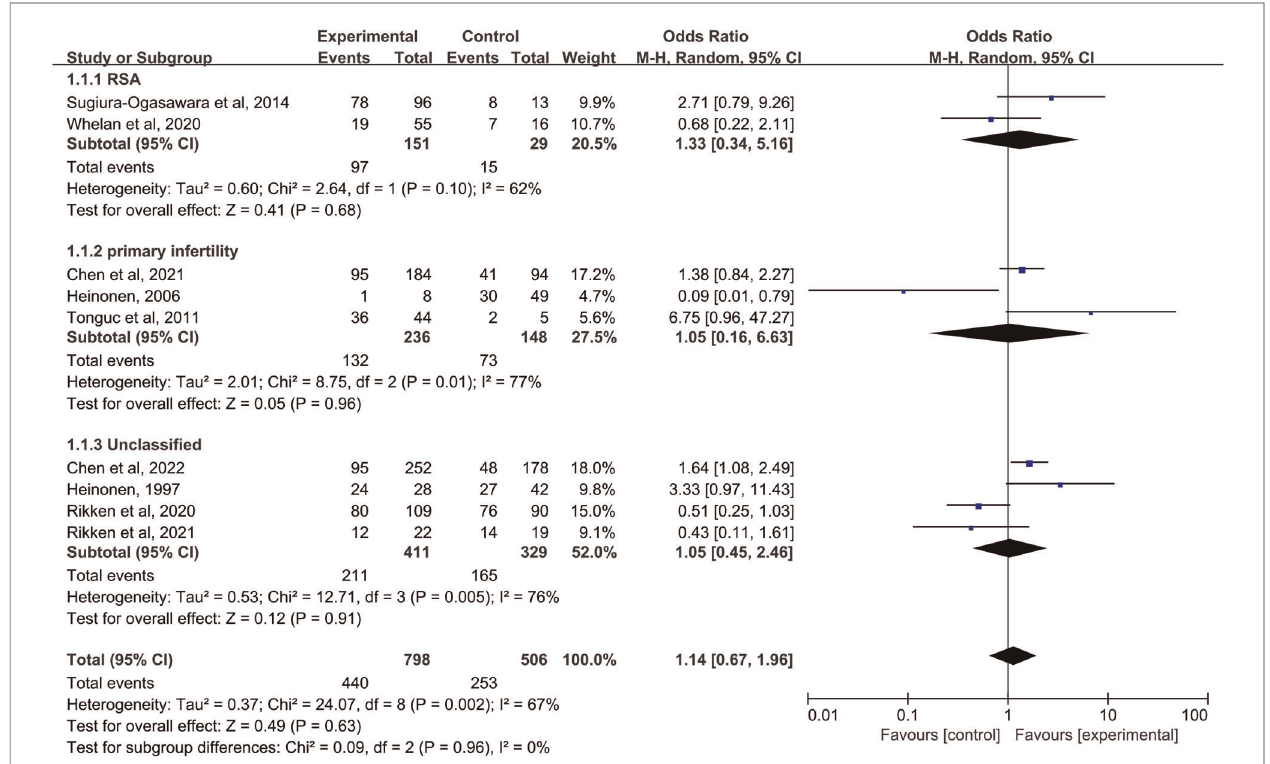
FIGURE 3 | Forest plot of live birth rate for treatment with hysteroscopic metroplasty group versus untreated